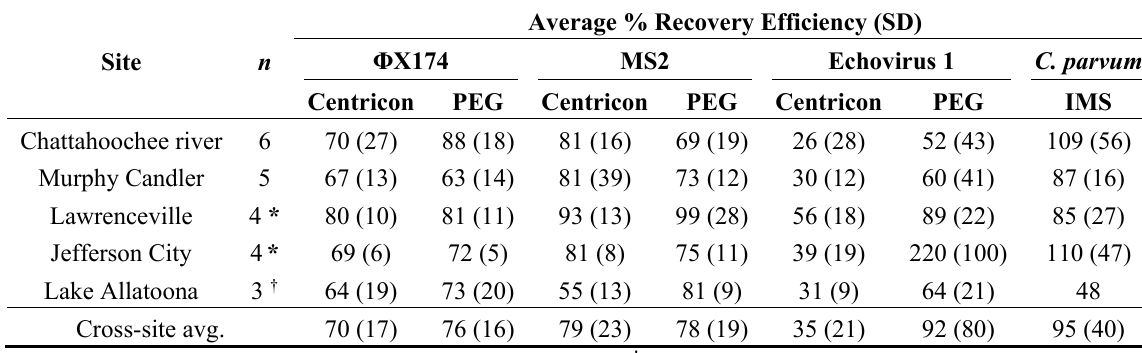
Table 3. Secondary concentration recovery